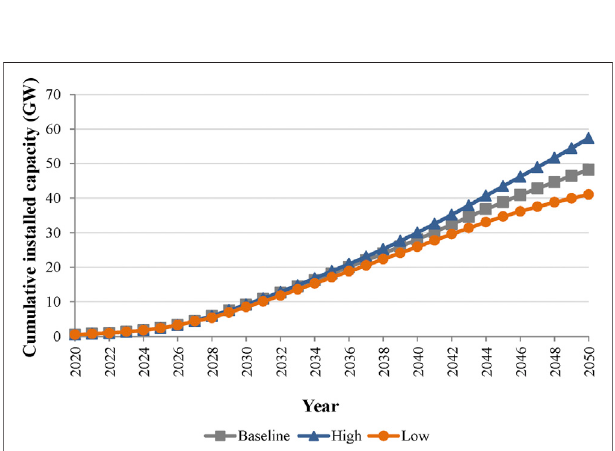
FIGURE 7 | Cumulative installed CSP capacity under different GDP growth rates.